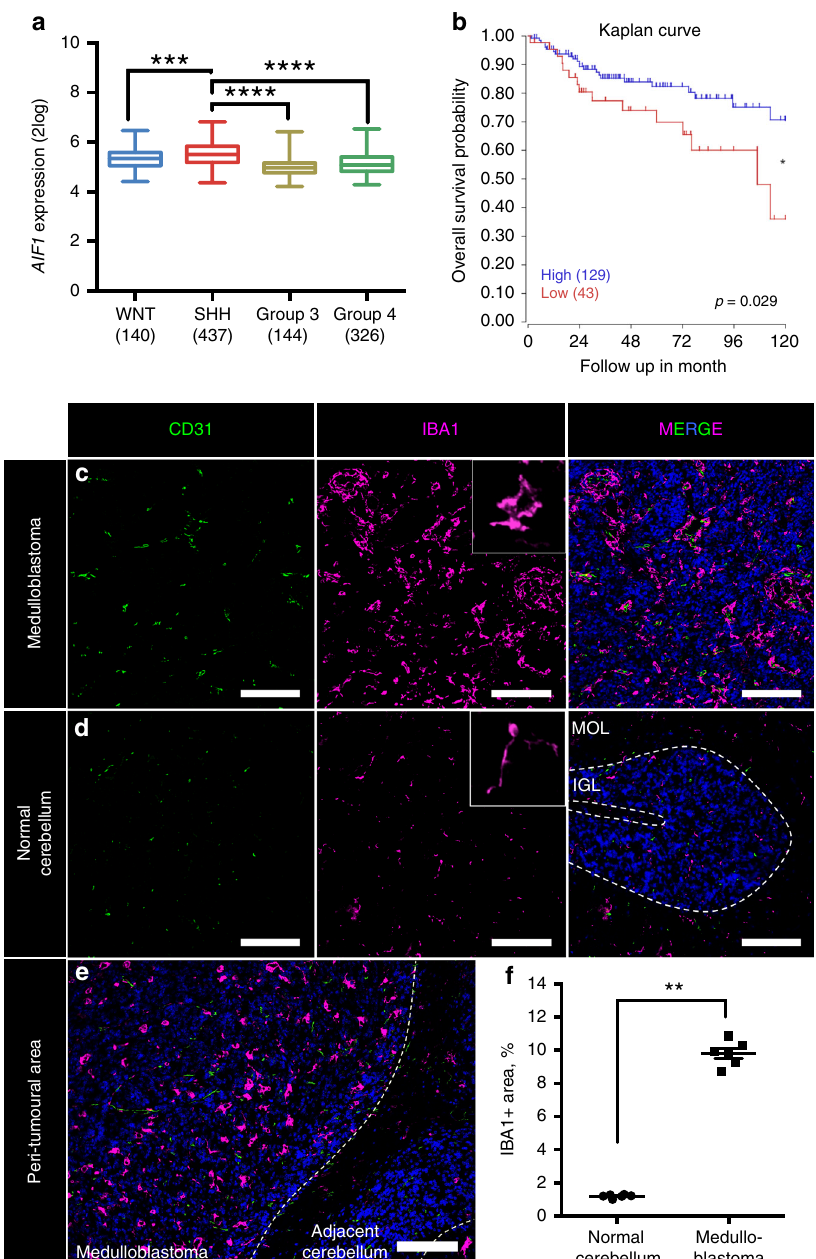
Fig. 1 SHH medulloblastoma has pronounced activation of TAMs. a Microarray data analysis of human patient cohort for AIF1 gene (from Cavalli et al. 13 ). WNT Wingless ( N = 140), SHH Sonic Hedgehog ( N = 437), N = 144 for group 3, and N = 326 for group 4. Box plots represent median and quratiles with whiskers indicating range of values. One-way ANOVA with multiple comparisons, F = 69.25, *** P < 0.001, **** P < 0.0001. b Kaplan – Meier graphs of patients with high ( N = 129, blue) and low ( fi rst quartile, N = 43, red) AIF1 expression, Log-rank Mantel – Cox test, * P < 0.05. c – e Immuno fl uorescent staining with macrophage marker IBA1 (magenta), endothelial marker CD31 (green), and nuclear marker DAPI (blue) of peri-tumoural area. Scale bars represent 100 µ m. f Semi-quantitative analysis of macrophage linear density by measuring area of IBA1 staining in normal cerebellum and medulloblastoma; each point represents analysis of at least fi ve images (×20 magni fi cation) from individual animals, mean ± S.E.M., N = 6, Mann – Whitney U test, ** P <